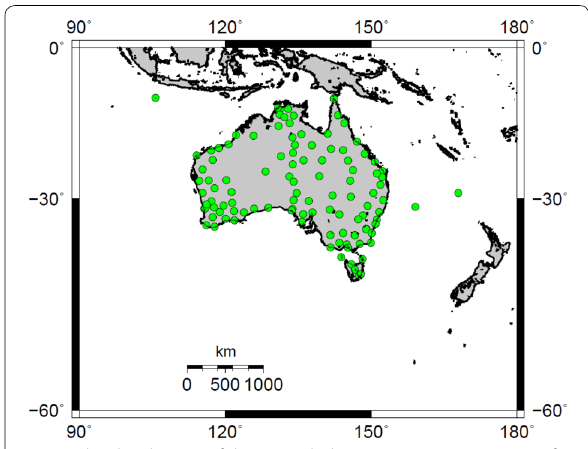
Fig. 3 The distribution of the extended 109 AFN stations in 2017 of